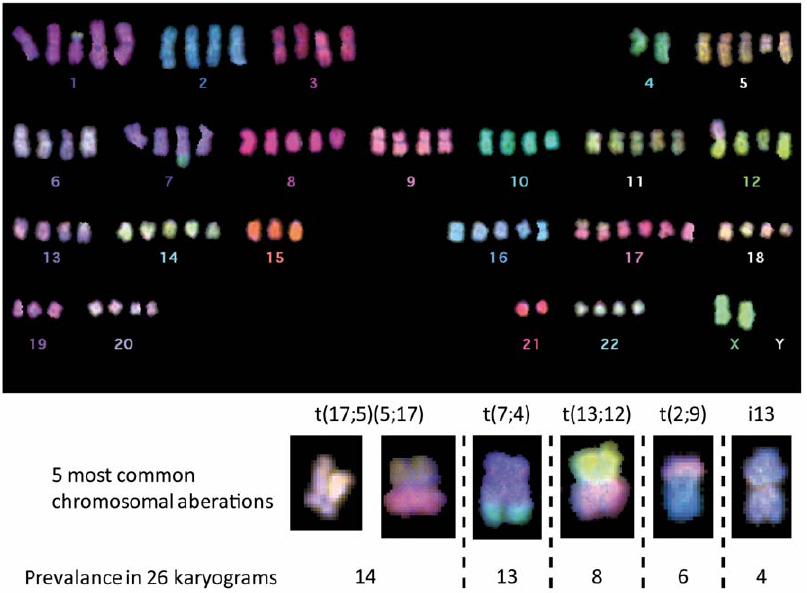
Figure 2. Karyogram and common chromosomal aberrations. A representative karyogram of JoPaca-1 is shown here. JoPaca-1 is a tetra- to penta-ploidic cell line. Below the overview picture, the five most commonly observed aberrations in 26 karyograms are presented. Translocations could be identified by hybridization of differently coloured probes resulting in dual-coloured chromosomes. Inversion of chromosome 13 (i13) is the fusion of two q-arms at the kinetochore. The Y-chromosome is often lost in tumour cells as it is in this